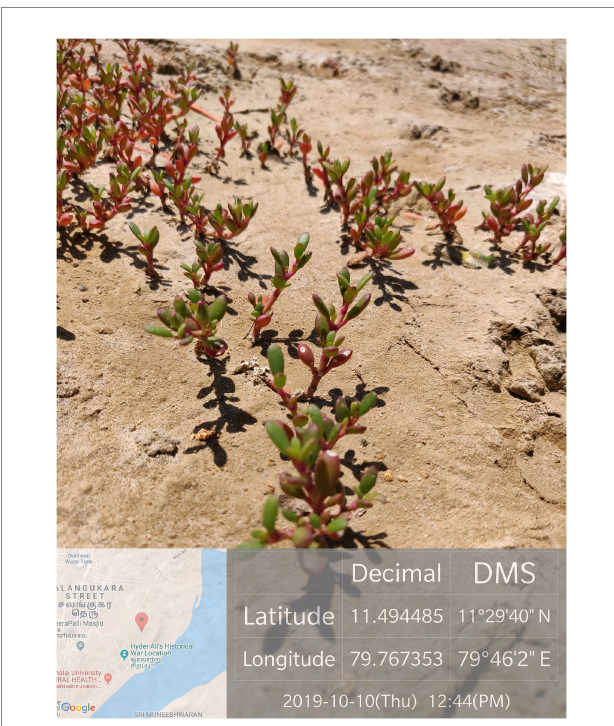
FIGURE 1 Collection of Sesuvium portulacastrum from the shores of backwaters at Parangipettai, Tamil Nadu,